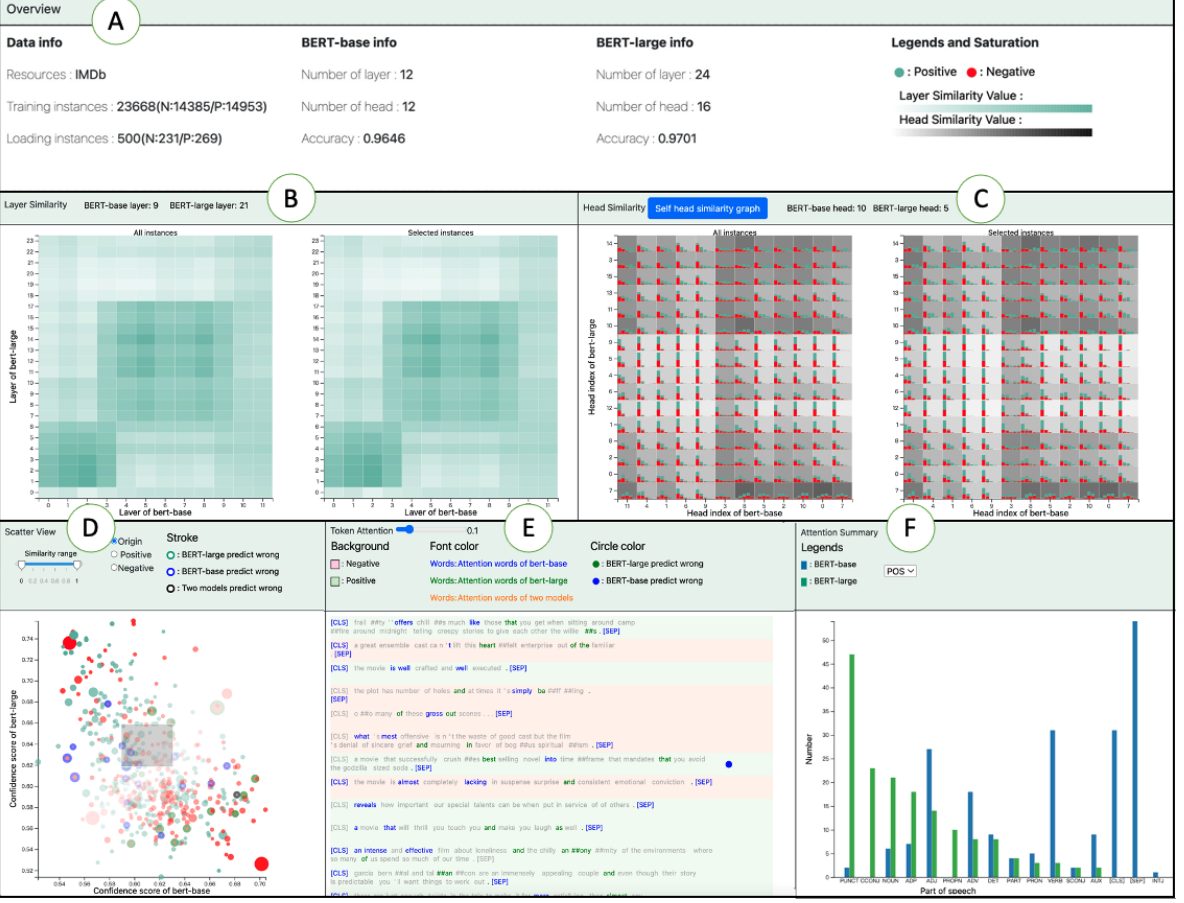
Figure 1. Our system contains six views. Overview ( A ) provides basic information about the model and visual reminders. The layer similarity view ( B ) visualizes layer similarity between the models. The left heat map in ( B ) is calculated based on all instances, and the right one is calculated based on the selected instances from ( D ). The head similarity view ( C ) calculates the similarity value of each head combination between the models. The left heat map in ( C ) is calculated based on all instances, and the right one is calculated based on the selected instances. Scatter view ( D ) shows the relation of confidence scores of instances and similarity at the instance level between the two models. The circle color indicates positive and negative instances. Attention view ( E ) shows the attention words of instances from two models and the ground truth in the model. The attention summary view ( F ) summarizes the statistic fundamental linguistic attribute of attention